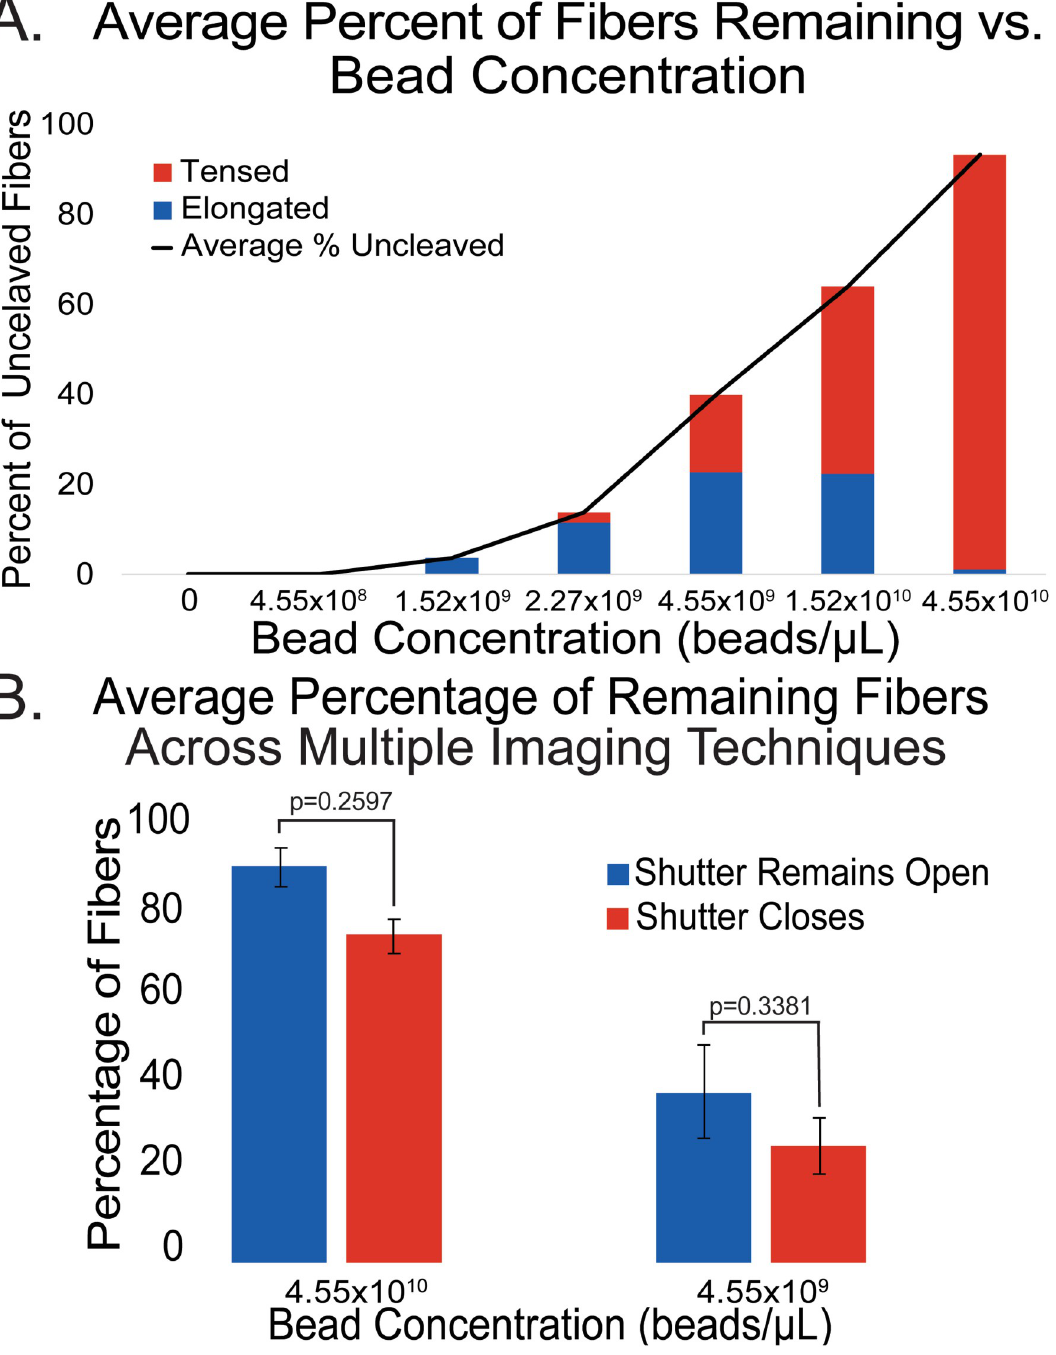
Fig 2. Percentage of Fibers Remaining After One-Hour of Imaging at Various Bead Dilutions and Various Light Doses: (A) The height of the bars represents the percentage of the total number of fibers that remain uncleaved after 1 hour of plasmin digestion. The bars are subcategorized by color to represent the fraction of uncleaved fibers that either remain tense (red) or elongate (blue). The total number of fibers analyzed for each of the bead concentrations are as follows: Nfiber = 32 (4.55x10 8 beads/ μ L); 85 (1.52x10 9 beads/ μ L); 82 (2.27x10 9 beads/ μ L); 103 (4.55x10 9 beads/ μ L); 86 (1.52x10 10 beads/ μ L); 85 (4.55x10 10 beads/ μ L). Note that fiber bundling is not differentiated in this plot but is in Fig 4. (B) The height of the bars represents the percentage of uncleaved fibers present after an hour of imaging. Data from two bead concentrations are presented. The bars are categorized by color based on the amount of light presented to the sample over the course of imaging; either constant light conditions with the camera shutter remaining open (blue) or low light conditions with the camera shutter closing after each frame of the time-lapse (red). At both 4.55x10 10 beads/ μ L and 4.55x10 9 beads/ μ L bead concentrations, there is no statistical difference between the percentage of uncleaved fibers with p-values of 0.2597 and